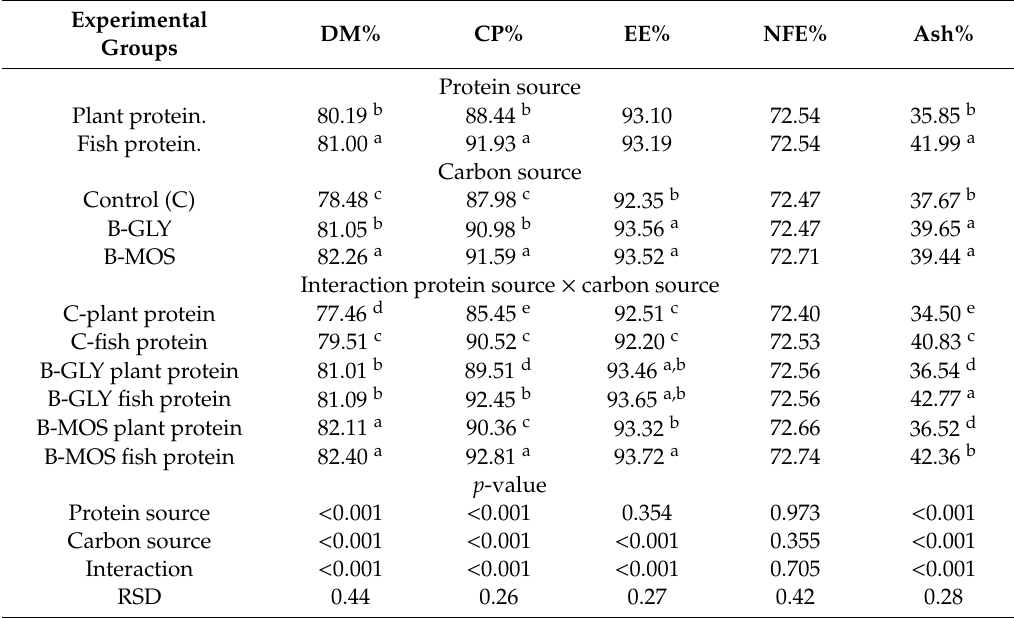
Table 5. The e ff ect of di ff erent dietary protein sources and carbon sources on Nile tilapia ( O. niloticus) nutrient